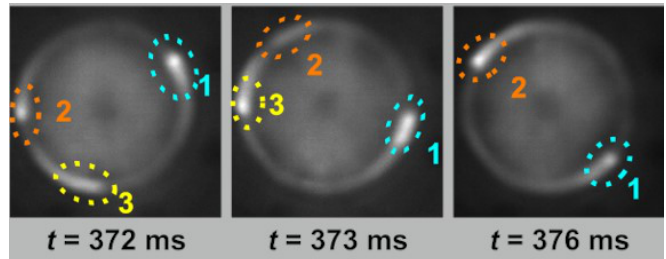
Figure 2. Experimental observations of RDRE exit plane during a three to two detonation